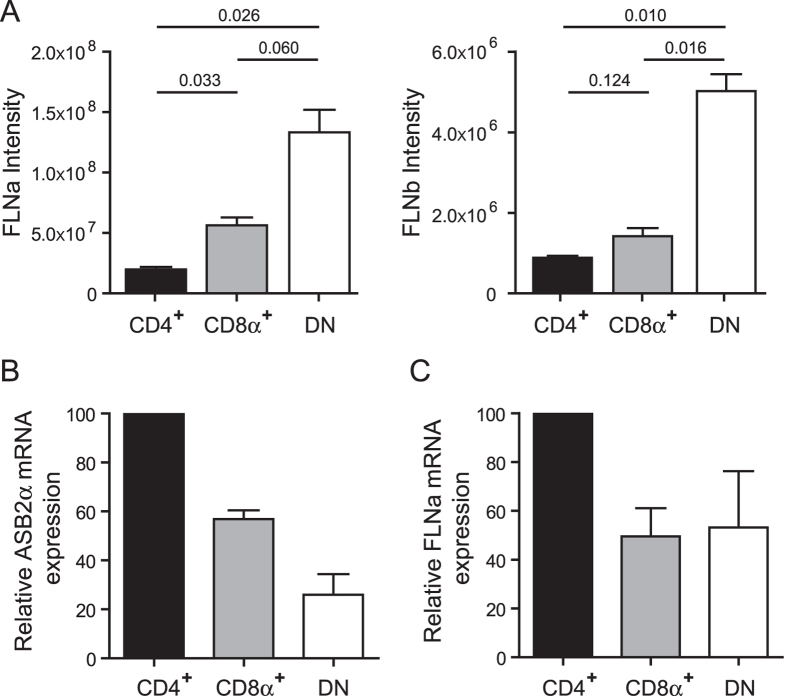
Expression of FLNa and ASB2α in mouse spleen DC subsets.(A) Intensities of FLNa (left panel) and of FLNb (right panel) calculated using MaxQuant quantitative metrics in CD11chiCD4+CD8α− (CD4+), CD11chiCD4−CD8α+ (CD8α+) and CD11chiCD4−CD8α− (DN) extracts. p-values were calculated with the unpaired t-test with Welch’s correction. Data plotted are from Luber et al.23 with courtesy of Meredith O’Keeffe. (B,C) Relative expression of ASB2α (B) and FLNa (C) mRNA assessed by RT-qPCR in CD4+, CD8α+ and DN cDC subsets in spleen of ASB2+/+ mice. Levels were normalized to Arbp. The data show means and SEM of three independent experiments (sample size: +/+ = 16).